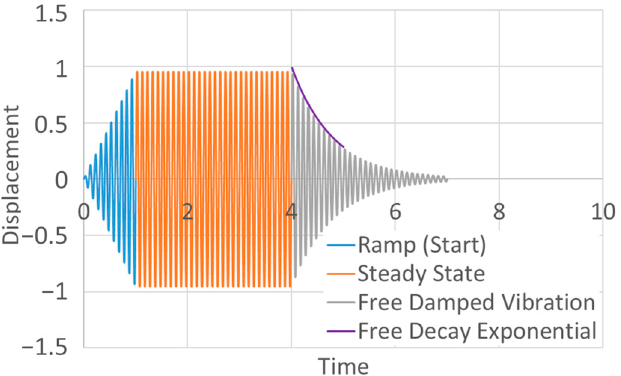
Figure 8. Schematic view of displacement during UHCF test for damping measurements.